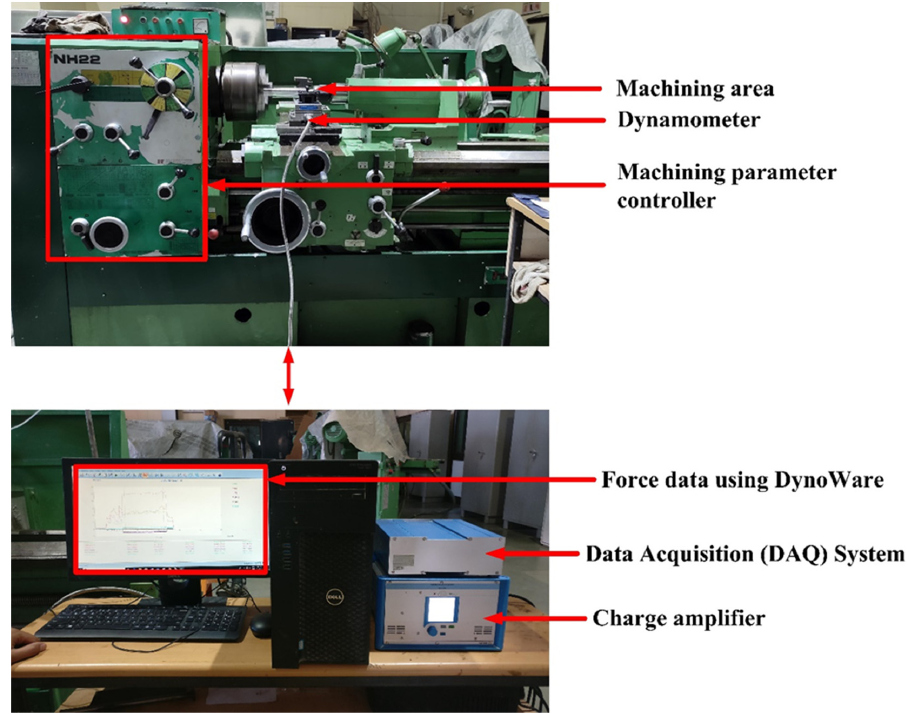
Figure 1. Photographic view of the machining setup with the dynamometer arrangement.